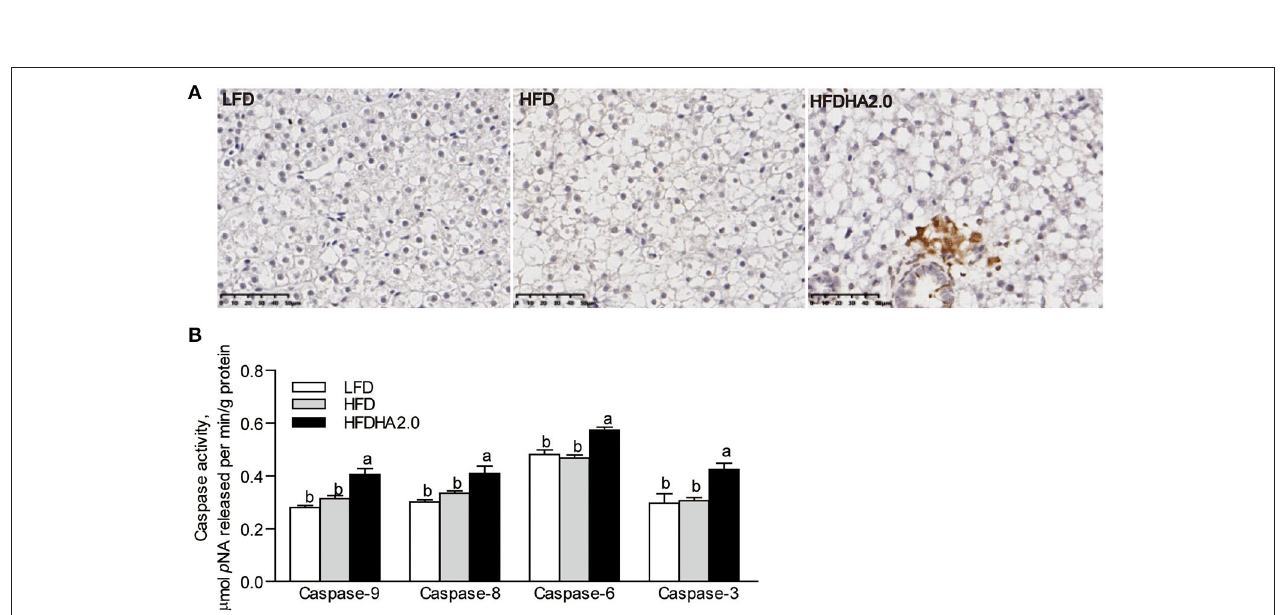
FIGURE 3 | The effects of DHA on liver apoptosis in zebrafish. (A) Tunnel staining of liver sections of LFD, HFD, or HFDHA2.0-fed zebrafish. The scale bar is 50 µ m. (B) The activities of caspase-9, caspase-8, caspase-6, and caspase-3 in LFD, HFD, or HFDHA2.0-fed zebrafish. The values are means ± SEMs ( n = 6 biological replicates). The mean values without a common letter are significantly different, p < 0.05. LFD, low-fat diet; HFD, high-fat diet; HFDHA2.0, 2% DHA-supplemented HFD.